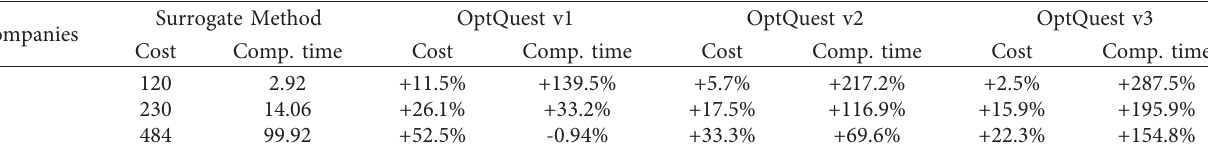
Table 4: Comparison between the Surrogate Method (dynamic η type 1) and OptQuest